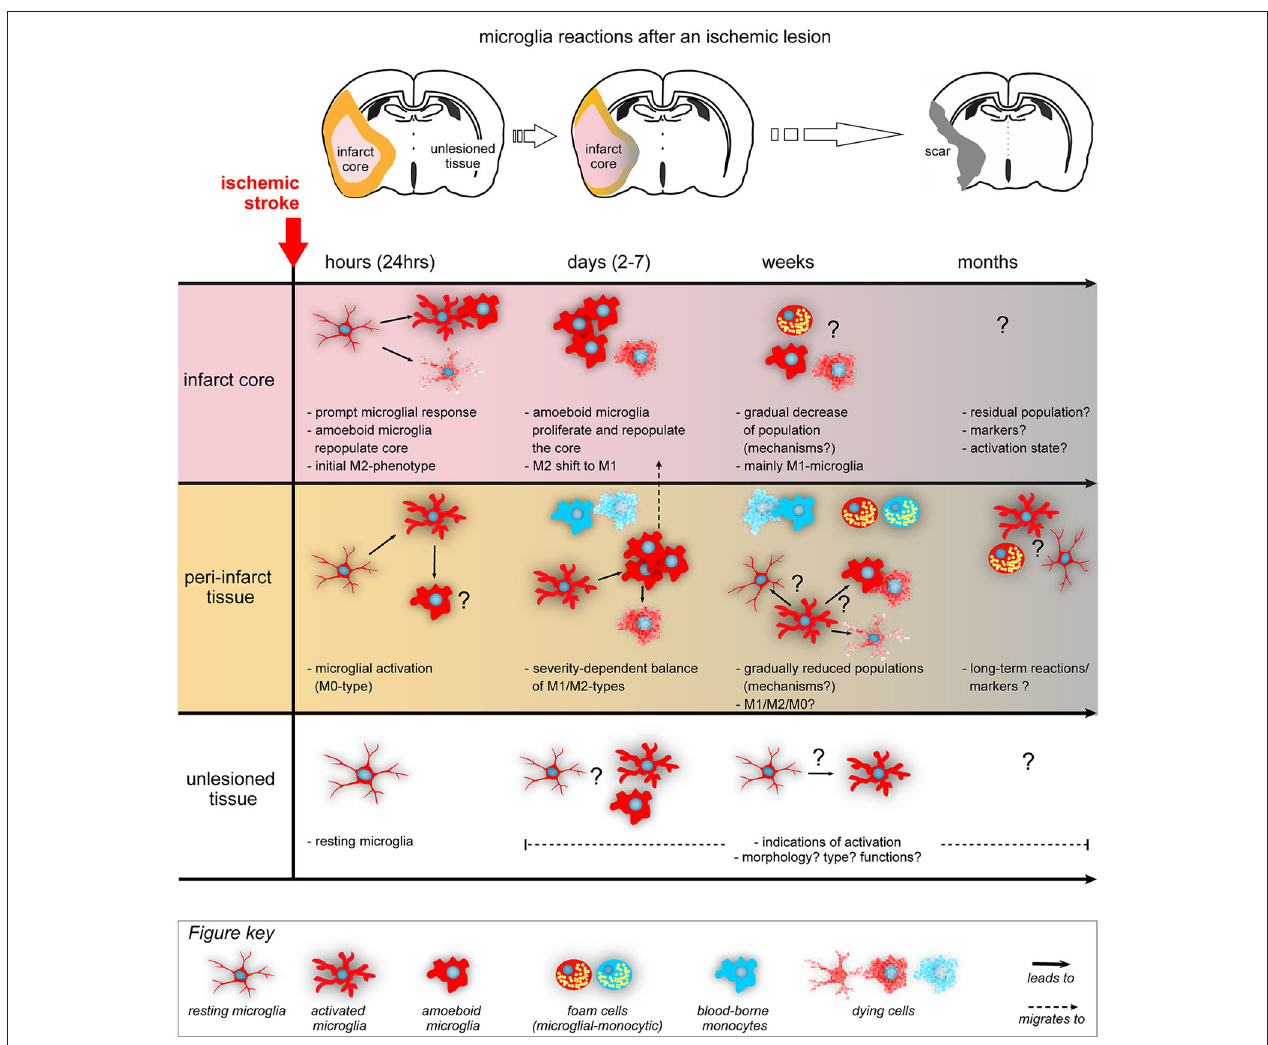
this period, blood-borne monocytes (blue cells) and lymphocytes and neutrophils (not shown here) infiltrate mainly the peri-infarct regions. During the subchronic phase ( weeks ), the core is further cleared from debris (amoeboid microglia turn into foam cells or die) and microglia in the peri-infarct area possibly follow regionally different paths (resting, activation or death), under processes not well studied so far. Foam cells are present (coming from both resident and blood-macrophages), while the numbers of blood-borne cells gradually decline. In the chronic phase ( months ), there are indications of long-term microglial activation and presence of residual foam cells in the peri-infarct tissue, with unknown significance so far. Importantly enough, the unlesioned tissue is not well studied so far but probably holds populations of activated microglia that respond or facilitate local degenerative processes. For the simplicity of the figure, we have not included the secreted cytokines produced by the microglia, their changes in their receptors and the contribution of other immune cells. M0: non-polarized microglia, M1: pro-inflammatory or classically activated microglia, M2: anti-inflammatory or alternatively activated microglia (Patel et al., 2013), “?” indicate lack of detailed